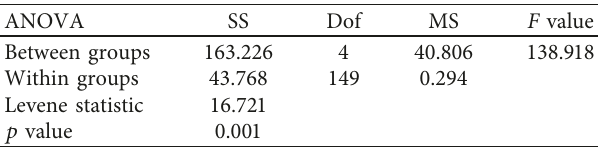
Table 6: ANOVA test between enhanced medical services to the patients and the application of blockchain technology in treating